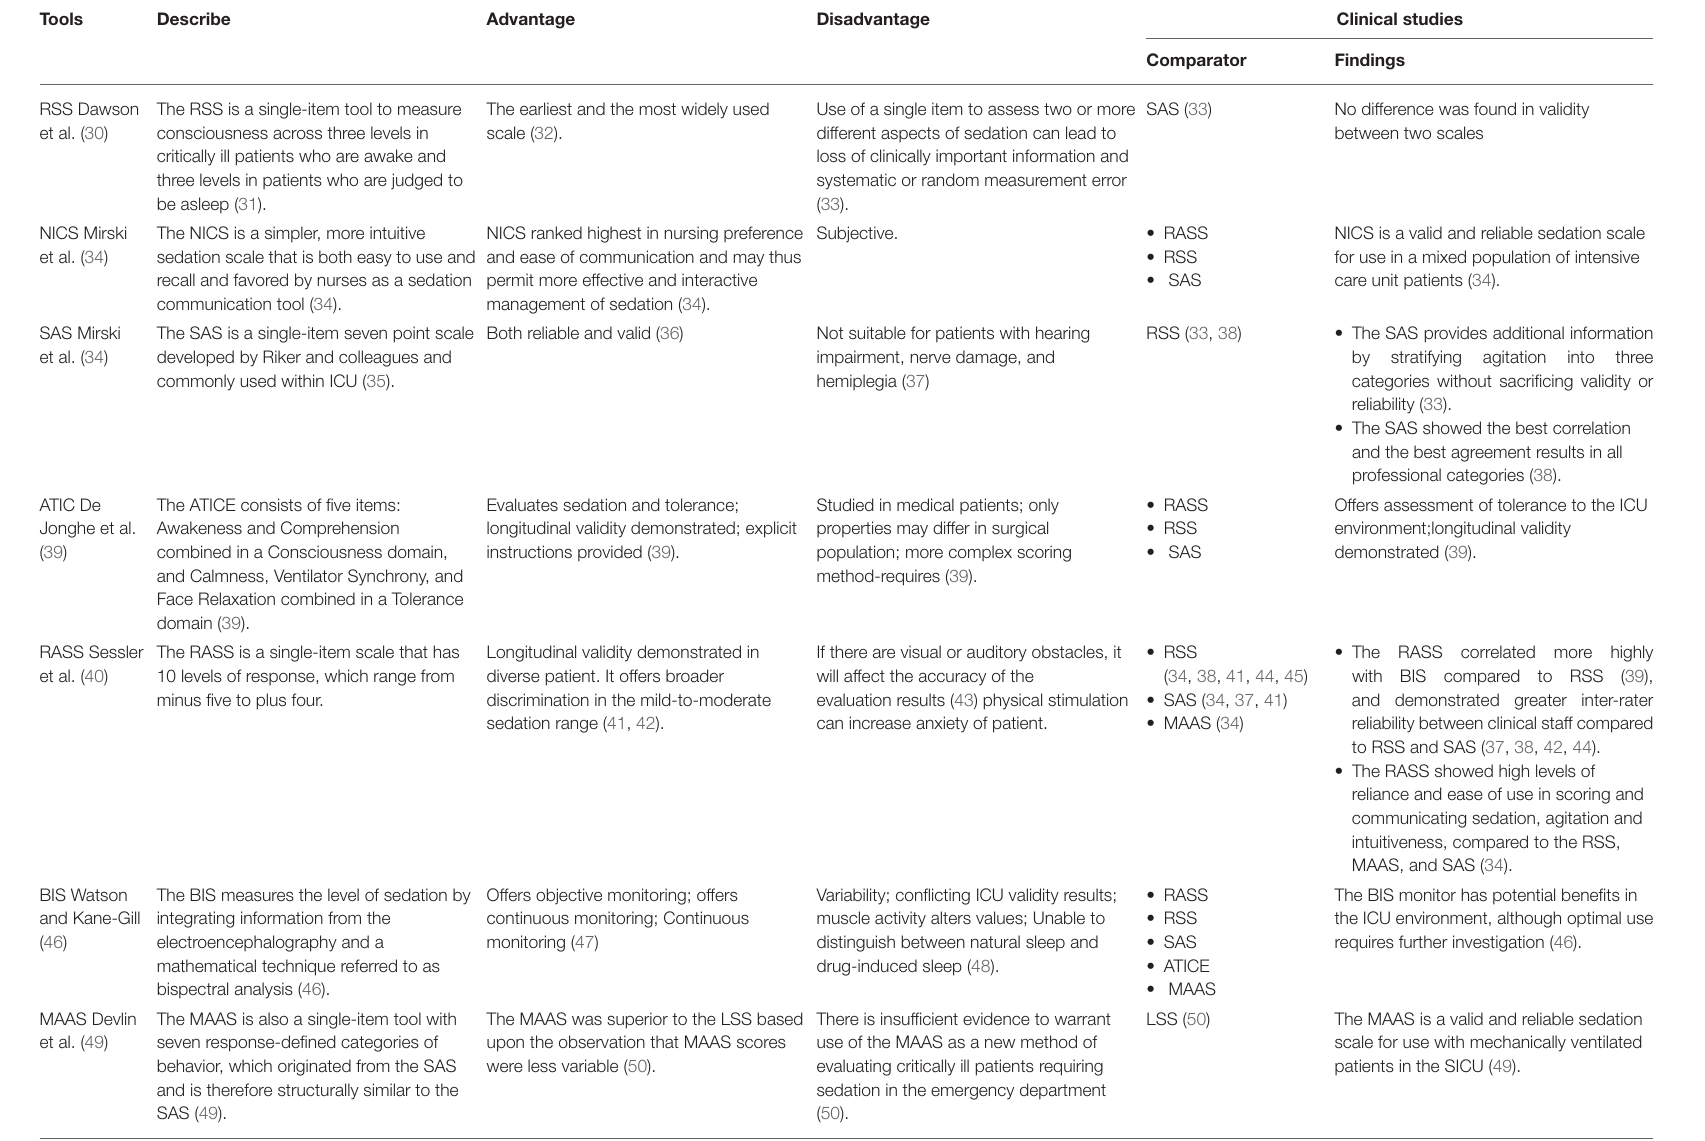
TABLE 1 | Tools for assessment of sedation depth or pain in mechanically ventilated patients. Tools Describe